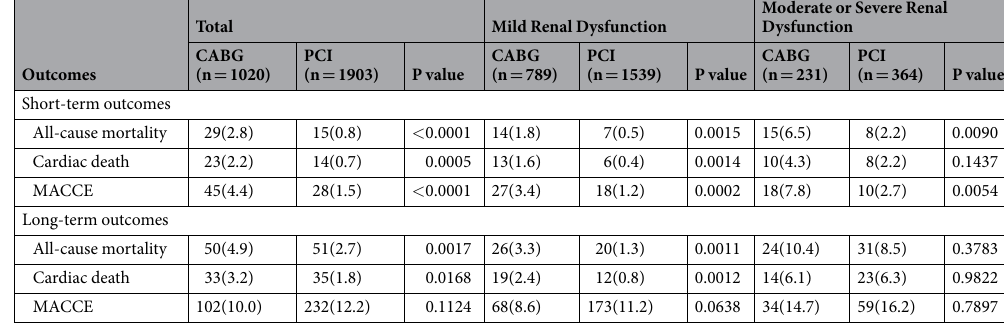
Table 2. Short-term and long-term clinical outcomes after revascularization. Number of patients and percentage. P value for short-term outcome was calculated using Breslow test. P value for long-term outcome was calculated by log-rank